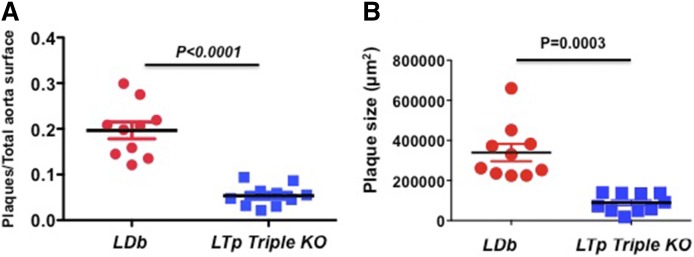
LTp mice develop significantly less atherosclerotic plaque compared with LDb mice. A: En face quantification of aortic atherosclerotic plaque. We quantified the lesions from the aortic arch to the iliac bifurcation of LDb males (n = 10) and LTp males (n = 10) at 5 months of age. The results are calculated as the ratio of aortic surface covered by plaque (in square millimeters) divided by the total surface area of the aorta (in square millimeters) and mean ± SEM is shown. We used two-tailed unpaired t-tests with Welch’s correction to analyze the difference between LDb versus LTp (P < 0.0001). The image with quantification value of each en face measurement is shown in supplemental Fig. S2A. B: The cross-sections of aortic sinus (n = 6 sections per animal) from each animal (LDb or LTp triple KO) were stained with Oil Red O. The plaque areas (in square microns) of each aortic sinus were quantified using AxioVision release 4.8 software (Zeiss). Each data point represents an average of six sections of each male animal (LDb = 10 and LTp = 10) at 5 months of age and their means ± SEM are shown. We used two-tailed unpaired t-tests with Welch’s correction to analyze the difference between LDb versus LTp (P = 0.0003). The image with the quantification value of each aortic sinus measurement is shown in supplemental Fig. S2B. The images of continuous image sections are shown in supplemental Figs. S3A and S3B.